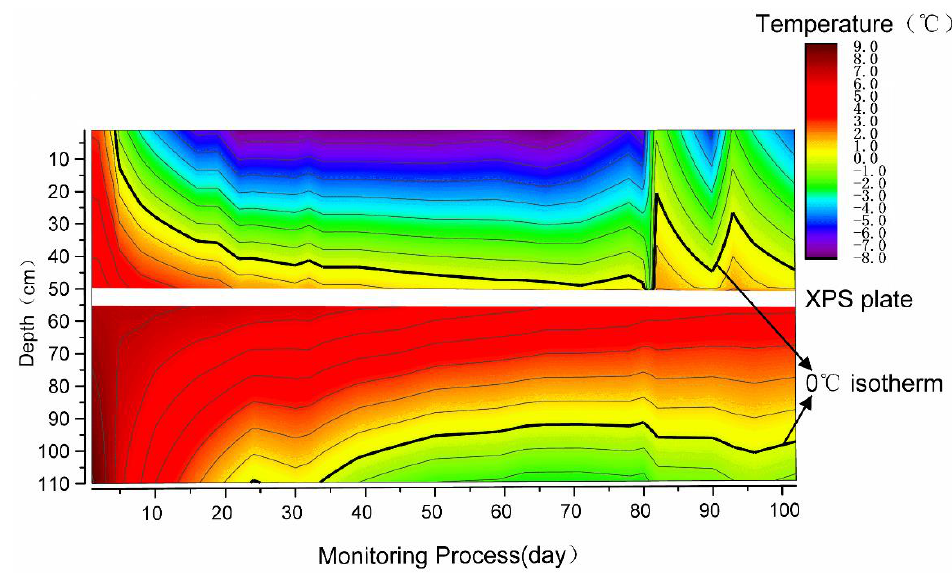
Figure 5. Temperature distribution map of the subgrade with a cold resistance layer.